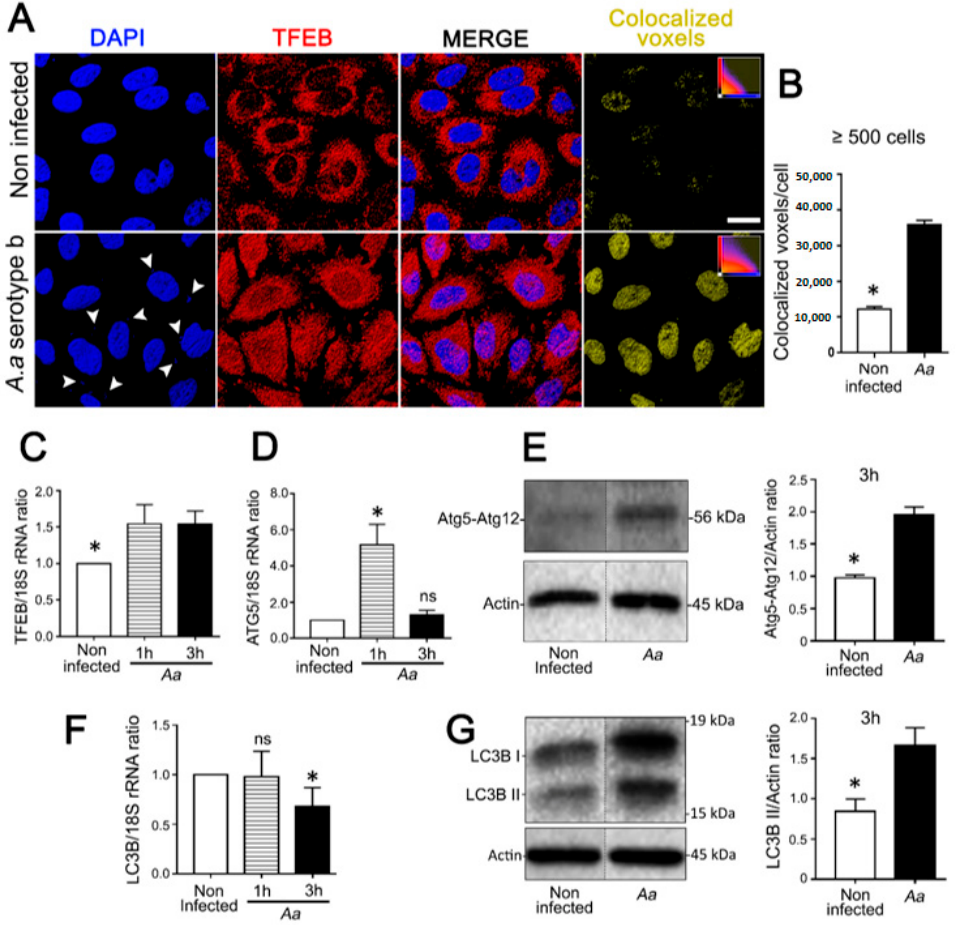
Figure 2. Assessment of autophagy markers in JEKs challenged with A. actinomycetemcomitans ( A.a ). OKF6 / TERT-2 cells were incubated with A.a (serotype b) at MOI = 200 and analyzed as follows: ( A ) Immunofluorescence staining visualized by confocal microscopy. Blue: DNA rich structures stained with DAPI; red: transcription factor EB labeled with anti-TFEB antibody; merge: digital overlap of blue and red channels; yellow: colocalized voxels from merged file. ( B ) Quantification of colocalized voxels is shown on the right (graph). ( C , D , F ) Relative quantification of transcripts encoding for TFEB (C), ATG5 (D), and LC3B (F) proteins by quantitative real-time PCR normalized to the 18S rRNA transcript levels. ( E , G ) Immunoblotting of protein extracts from OKF6 / TERT-2 cells incubated with antibodies against the specified autophagy-related proteins. β -actin protein was employed as a loading control. Densitometric quantitation of actin-normalized protein bands is indicated on the right. The results are shown as the average of the actin normalized data from three independent experiments. * p < 0.05. Results from (A,E,G) were obtained after 3 h of the bacterial challenge. The vertical dotted lines in (E,G) separate signals that were non-adjacent in the developed membrane.